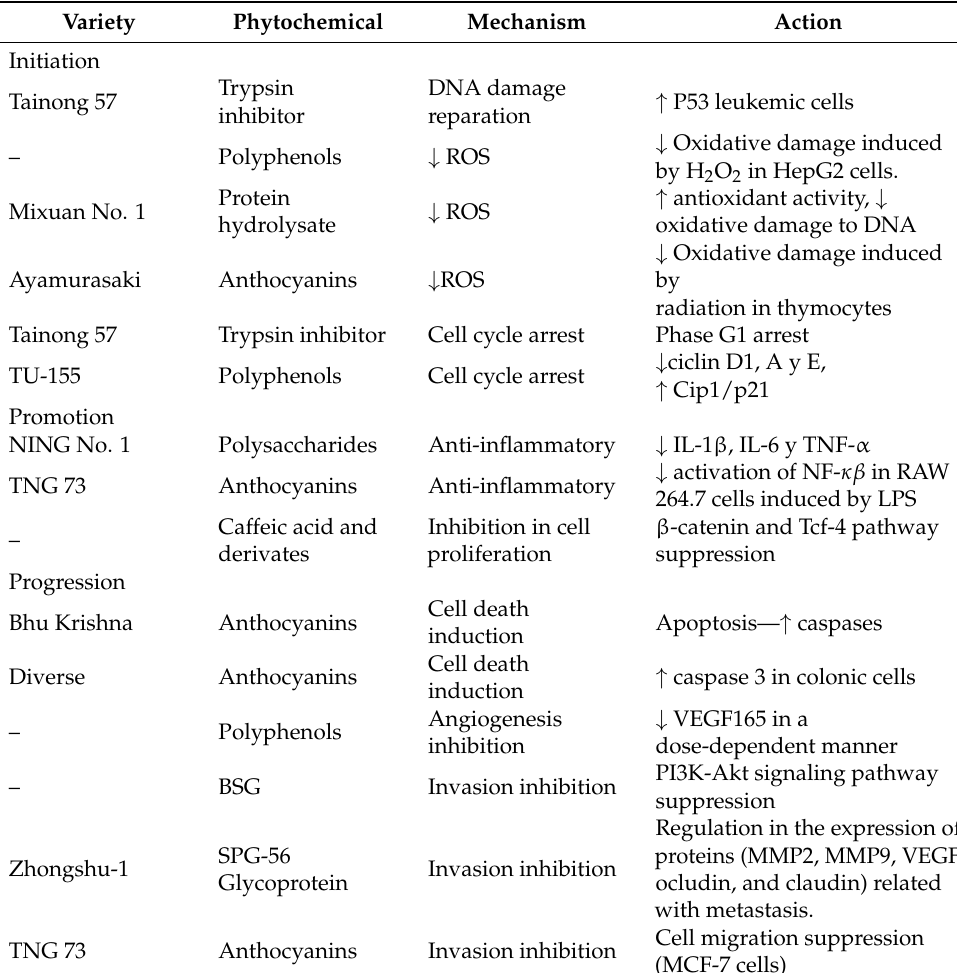
Table 4. Bioactive compounds in SP and their role against cancer. Variety Phytochemical